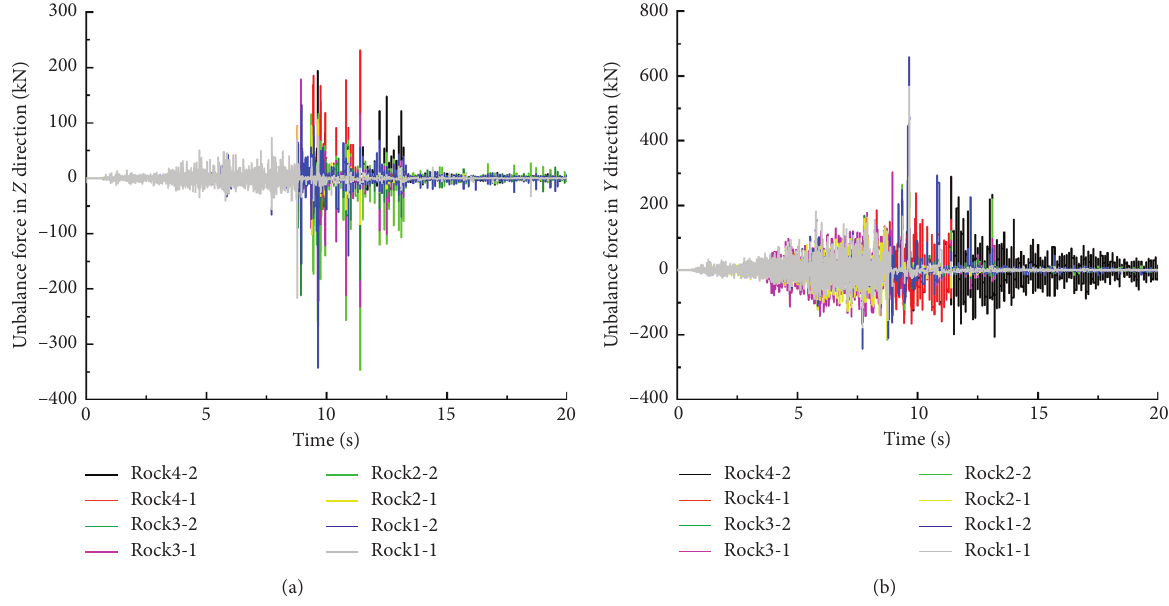
Figure 21: Time history curve of unbalanced force. (a) Vertical z -direction. (b) Horizontal y